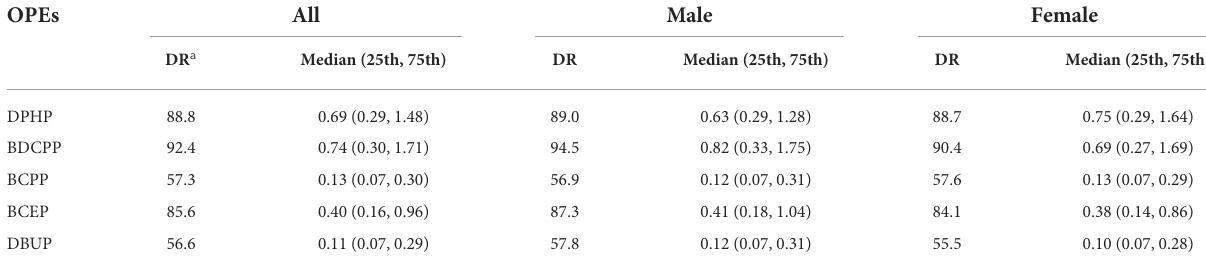
TABLE 2 Detection rates (%), concentration (ng/ml) of urinary organophosphate esters in all men and women. OPEs